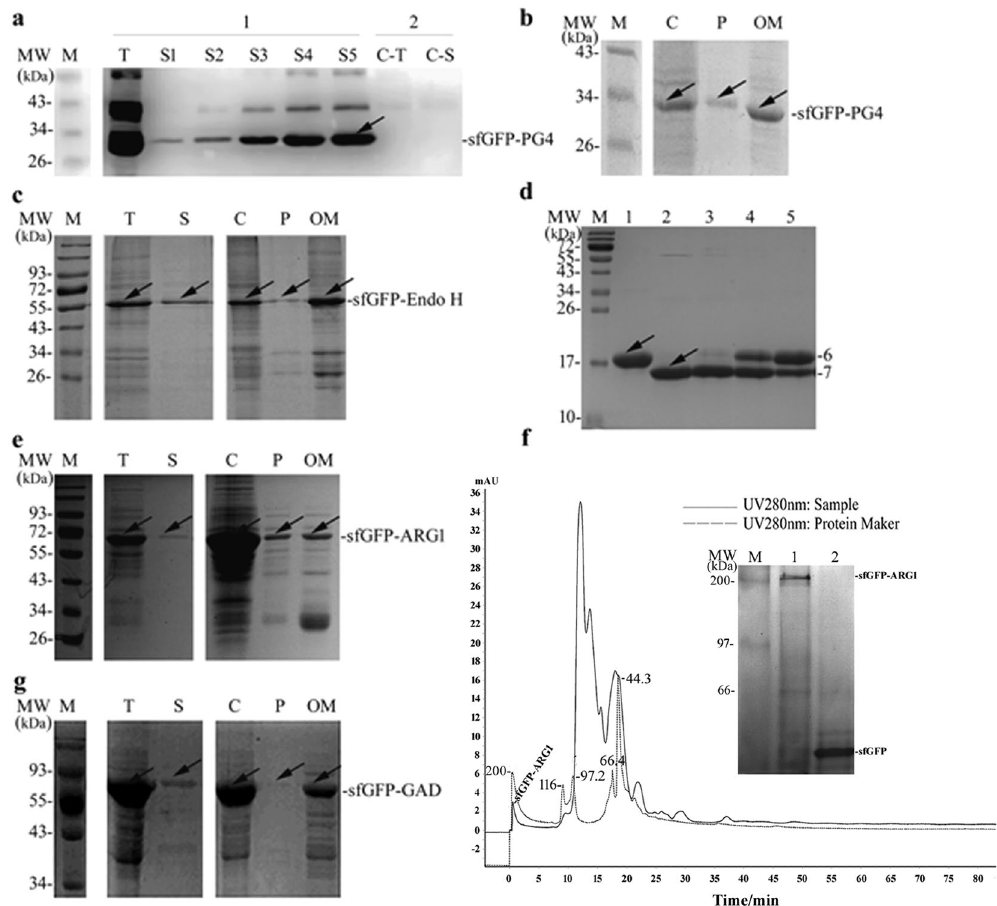
Figure 4. Analysis the auto secretion of sfGFP fusionsin E . coli . ( a ) Western Blot analysis of the extracellular expression of the sfGFP-PG4 in E . coli ; C-T: total cell protein of the control; C-S: extracellular protein of the control; S1~S5: after expression, supernatant protein sample of culture media stayed in room temperature for one to five days; ( b ) SDS-PAGE analysis of the sub-fraction of the sfGFP-PG4 in E . coli ; ( c ) SDS-PAGE analysis of the sub-fraction of sfGFP-Endo H in E . coli ; ( d ) Enzyme activity analysis of sfGFP-Endo H; 1: native protein Rnase B; 2: native protein Rnase B digested by the recombinant protein Endo H (New England Biolab); 3~5: native protein Rnase B digested by sfGFP-Endo H (dilution 1:100, 1:1000, 1:10000); ( e ) SDS-PAGE analysis of the sub-fraction of sfGFP-ARG1 in E . coli ; ( f ) Exclusion chromatography and SDS-PAGE analysis of sfGFP- ARG1; Lane 1: un-denatured sample of fusion protein sfGFP-ARG1; Lane 2: denatured sample of sfGFP; ( g ) SDS-PAGE analysis of the sub-fraction of sfGFP-GAD in E . coli ; T: total cell proteins; S: supernatant of culture media; C: cytoplasmic protein; P: periplasmic protein; OM: outer membrane protein.